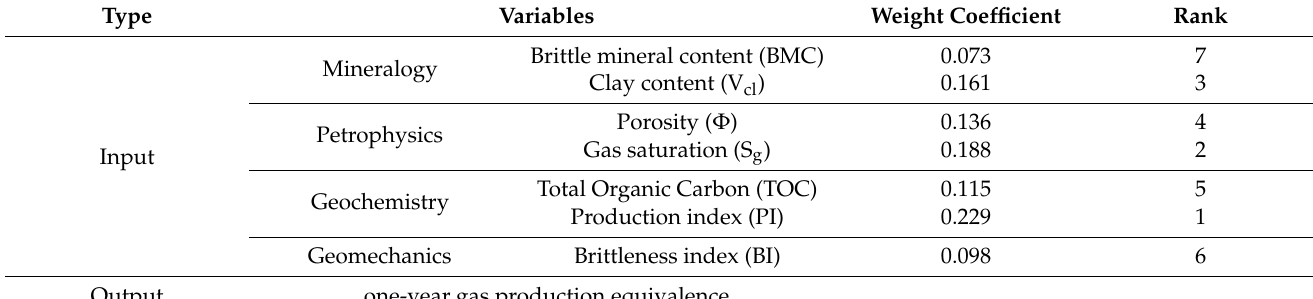
Table 2. The MLR results for shale gas production equivalence in the studied region.